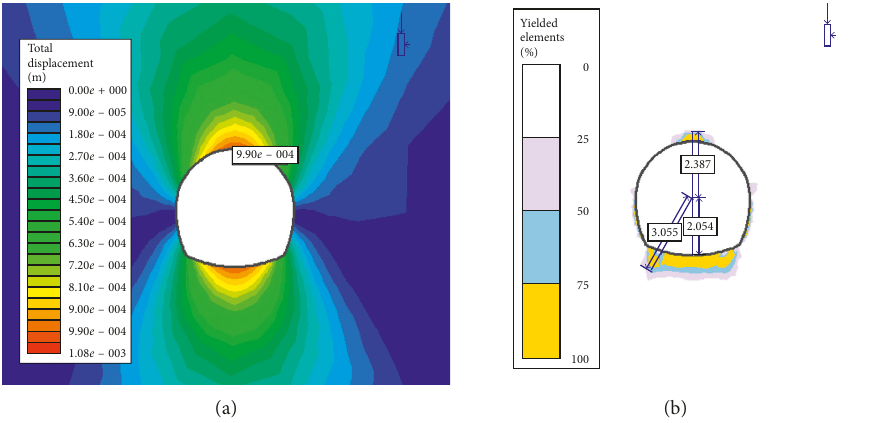
Figure 6: Total displacement (a) and yield elements (b) with plastic zone (50%) before supports.